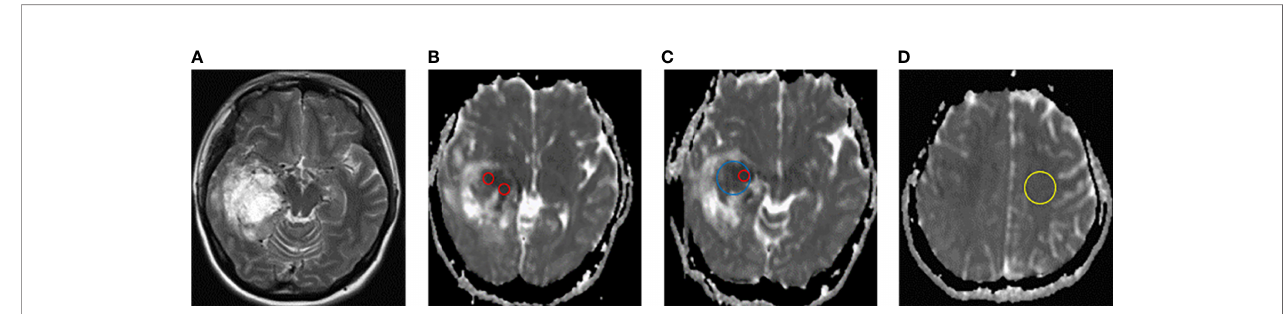
FIGURE 1 | Schematic diagram of ADC measurement. (A) T2W axial map of IDH-wild type glioblastoma of the right temporal lobe. (B – D) ADC diagram ROI delineates sketch. ADC min (ROI of 3 lowest visual ADC values for each patient, red circle), ADC mean (maximum cross-section of axial solid tumor, blue circle), and ADC nawm (contralateral hemisphere centrum semiovale normal appearing white matter, yellow